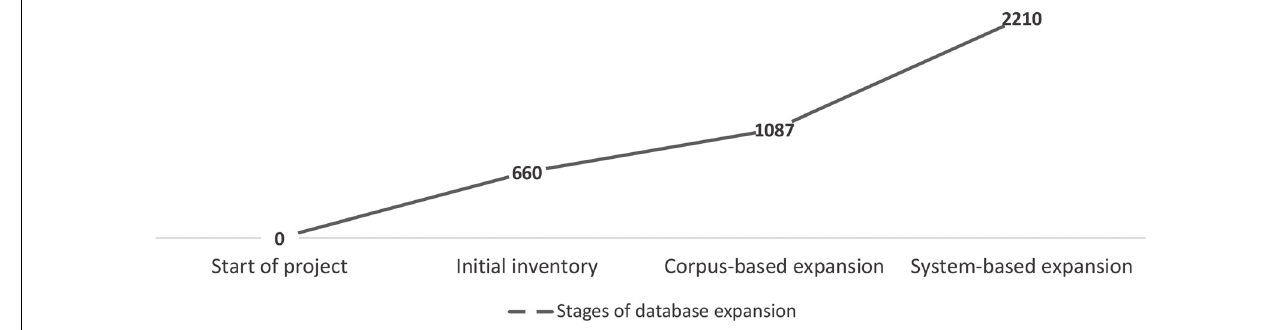
FIGURE 2 | Stages of database expansion and the cumulative size of the database at each